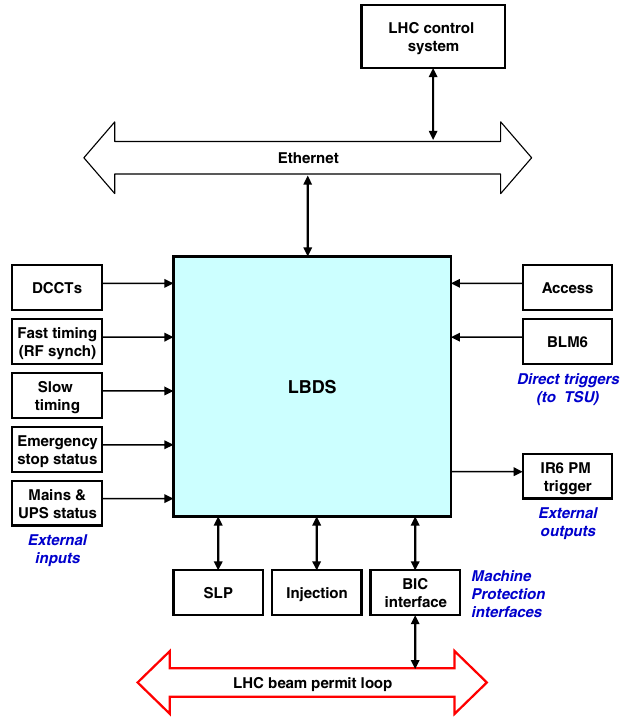
FIG. 5. (Color) LHC beam dump system interfaces with other LHC